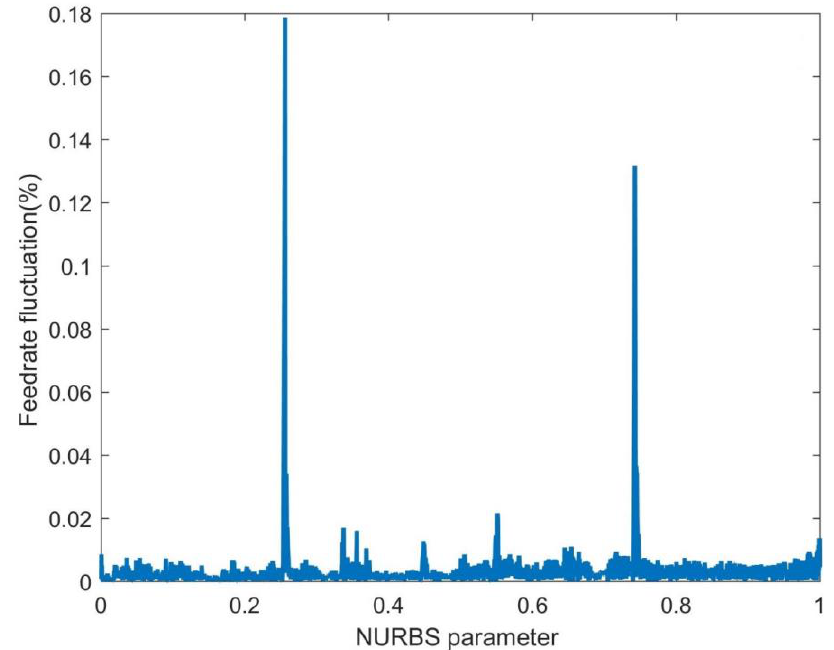
Figure 9. The feedrate fluctuation of the SAM with the first-level parameter compensation.